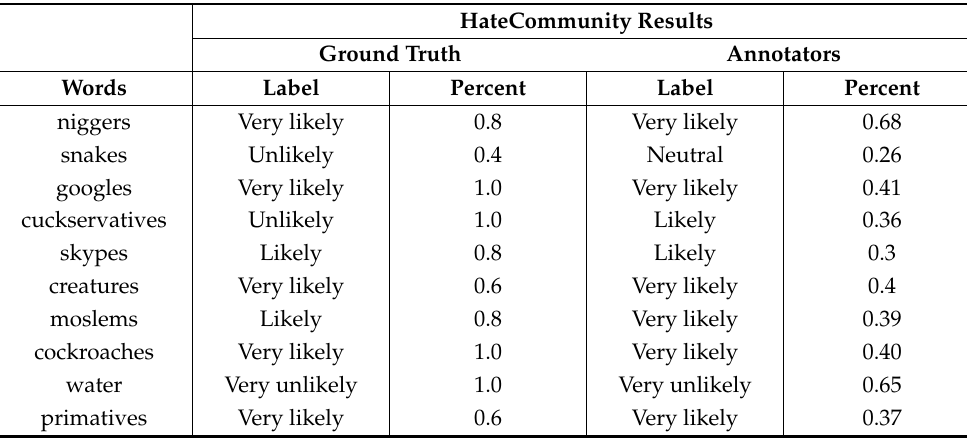
Table 5. HateCommunity Word: Ranking